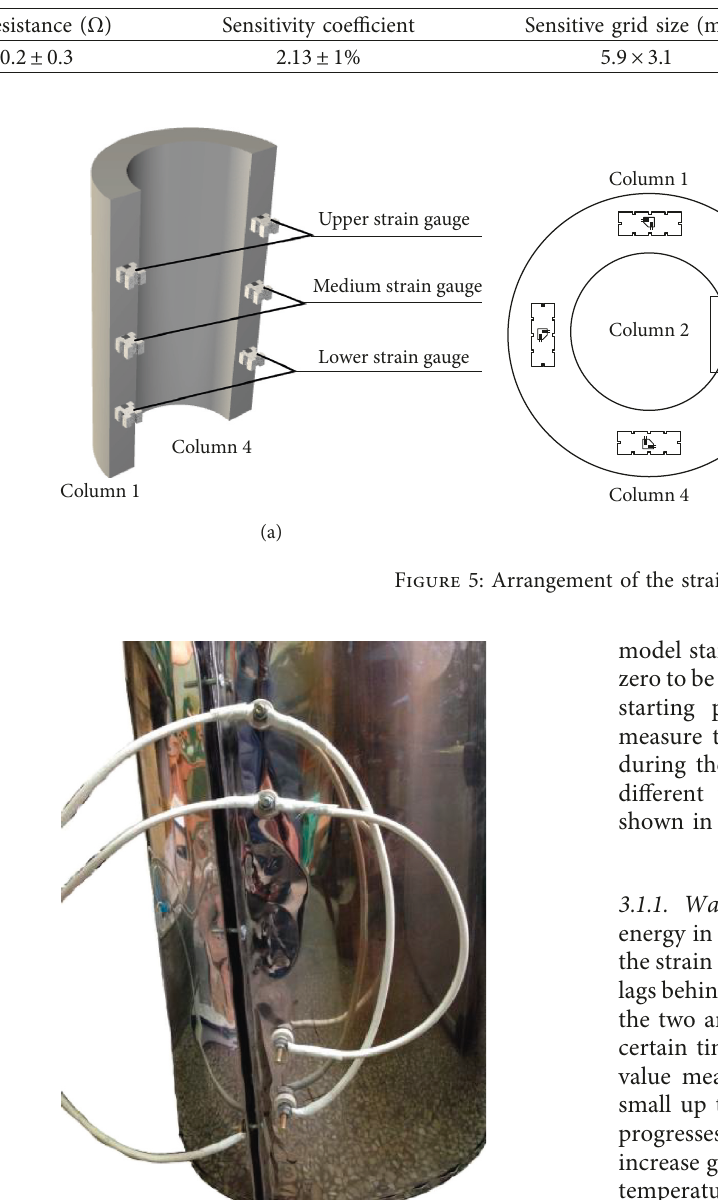
Figure 6: Electric heating equipment and interstar